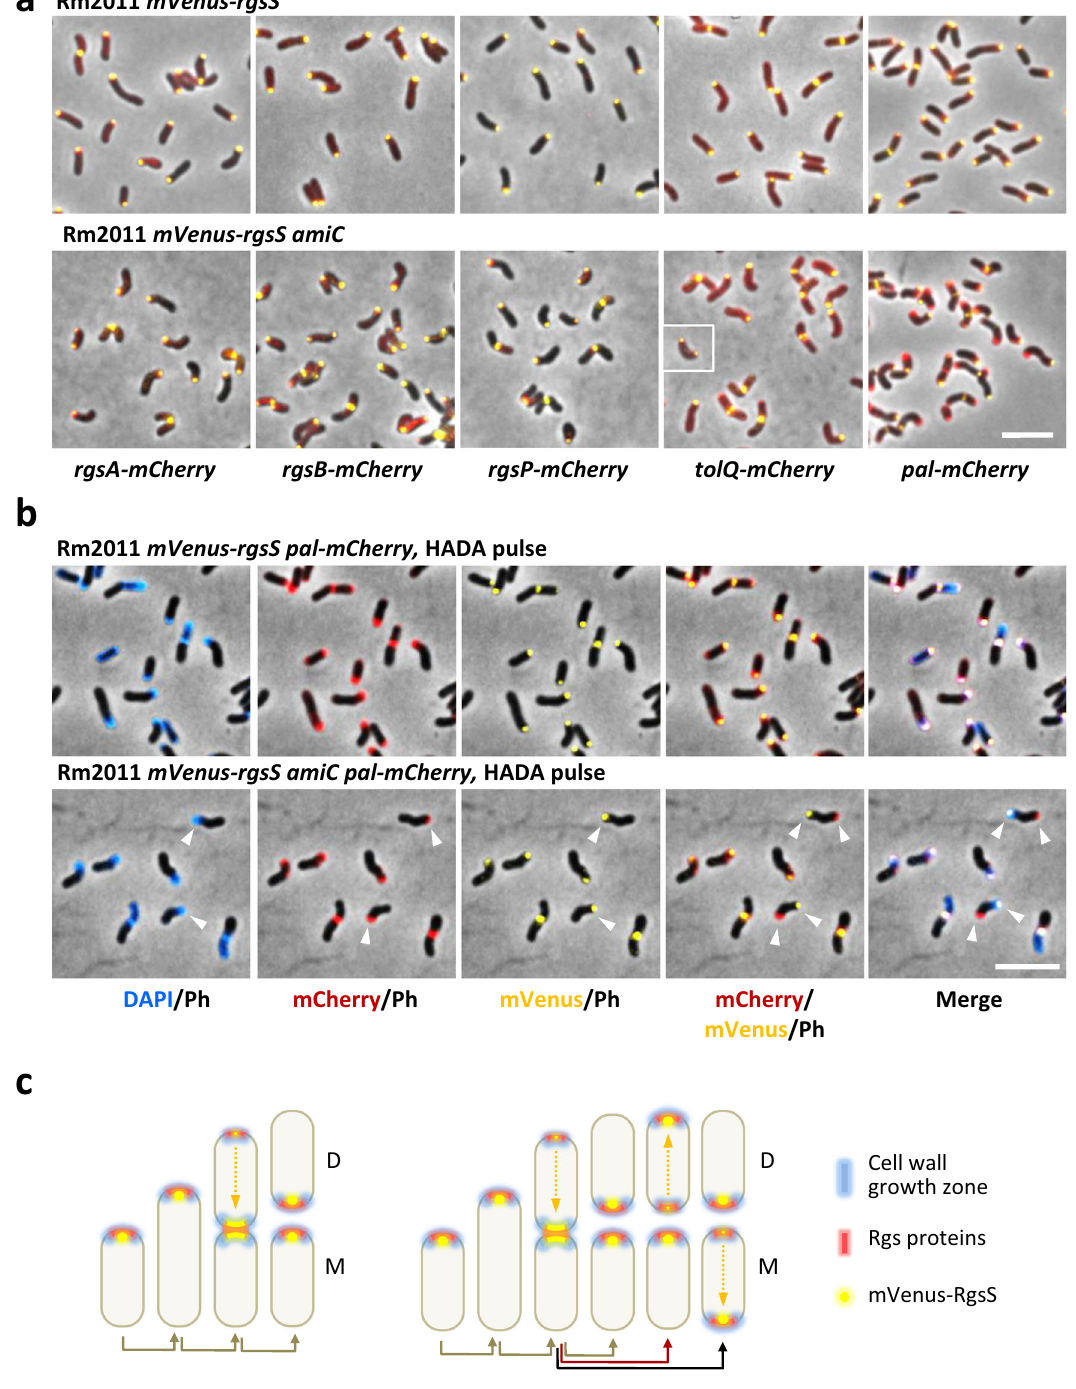
revealed that Pal-mCherry faithfully colocalized with mVenus- RgsS in wild type cells (Supplementary Fig. 17). In amiC -de fi cient cells, which inherited mVenus-RgsS at the old cell pole, Pal-mCherry was retained at the new cell pole and accumulated de novo in the course of cell elongation at the old cell pole (Supplementary Fig. 17). Thus, we considered divergent mVenus- RgsS and Pal-mCherry localization as a marker of cells with mVenus-RgsS focus at the old cell pole. Pulse-labeling with HADA revealed conjoint positioning of PG incorporation zones